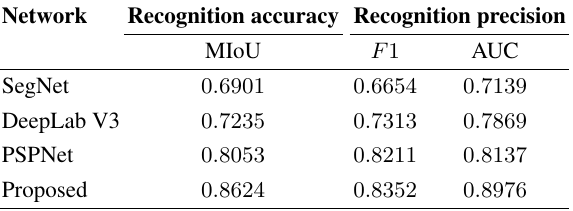
Table 2. Landslide recognition evaluation results of four